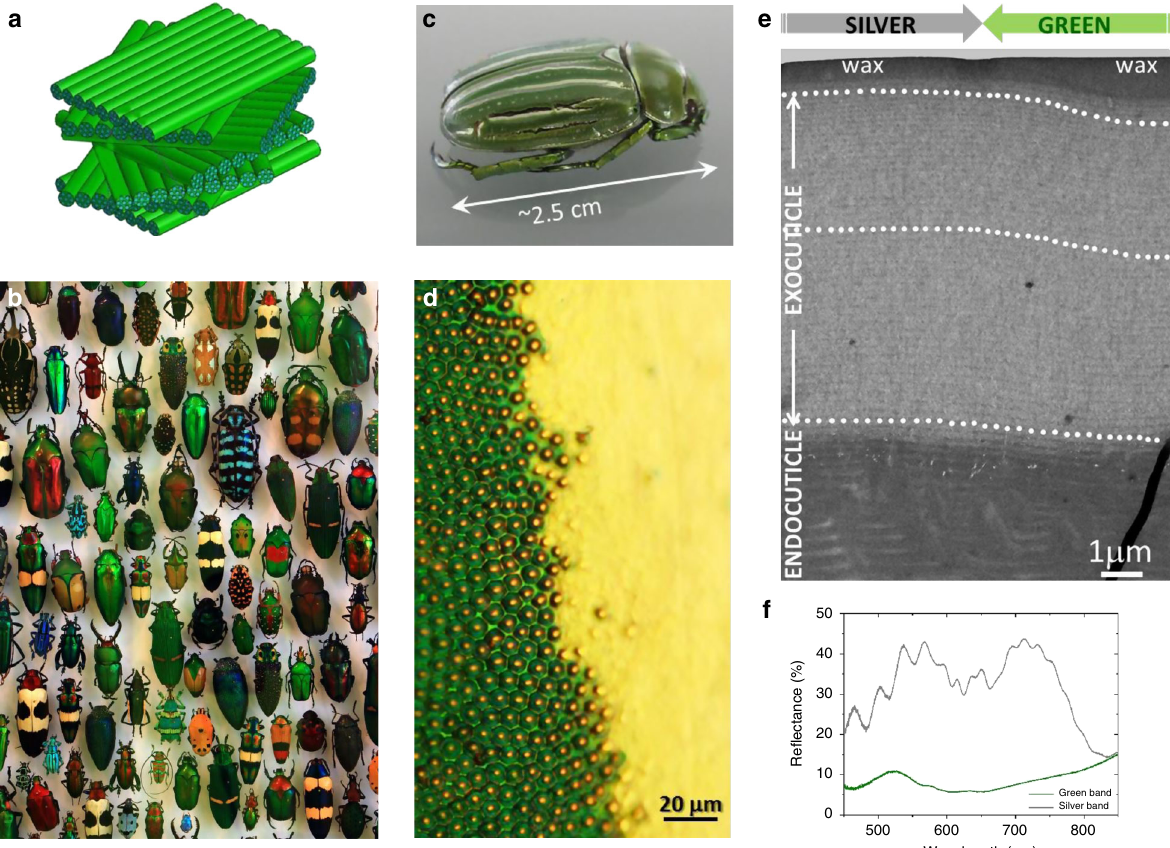
Fig. 1 Lessons from nature. a In the insect cuticle, chitin macromolecules form fi brils that wrap with proteins and assemble into fi bres, which assemble into bundles. The bundles arrange themselves parallel to each other and form pseudolayers. Finally, the chitin fi bre-protein layers stack into a twisted plywood Bouligand structure 7 . The structure is not a discrete multilayer system; instead, a continuous twist occurs along the axis perpendicular to the fi bres, which interpenetrate from one pseudolayer to the next. For this reason, the term pseudolayer is preferred over layer. A 360° rotation of the fi bre orientation de fi nes the helical pitch. (Adapted from ref. 75 . Creative Commons license.) b The insect world includes a very large variety of tessellated (patterned) cuticles with bumps, pits, pixels, bands, spots or patches and a diversity of structural colors (Staatliches Museum für Naturkunde, Karlsruhe, Germany. Image by H. Zell. Creative Commons license). c Two-band iridescent cuticle of Chrysina gloriosa . d Green and silver bands at their interface as observed by optical microscopy (re fl ection mode, unpolarized light). e TEM images of transverse structures at the interface between green and silver bands and close to the top surface. White dots underline the stripes in the fi ngerprint texture. The transition between curved and straight stripes is observed to be very gentle. The last part of the cuticle consists of a wax layer 76 , which may serve to restrict water loss and prevent desiccation 77 . f Re fl ection spectra of green and silver